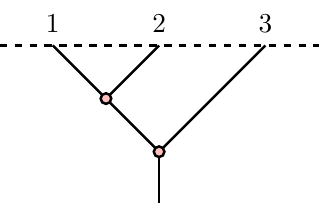
Figure 2 . Binary tree [[1,2],3] for 3-point currents. One can understand the dashed line as the boundary of spacetime. In our following calculation, we focus on the AdS background, but this representation is also correct for the dS